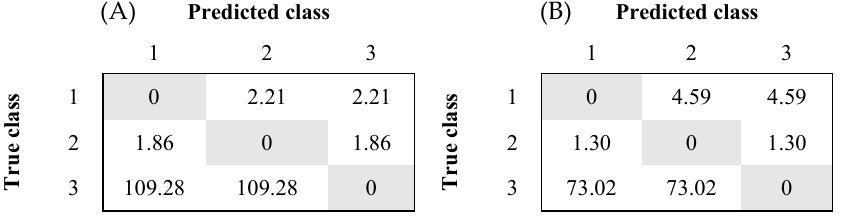
Figure 1. Penalty matrices were used for datasets ( A ) (left) and ( B ) (right) based on Equation (1). The rows represent the true classes, while the columns represent the predicted classes.